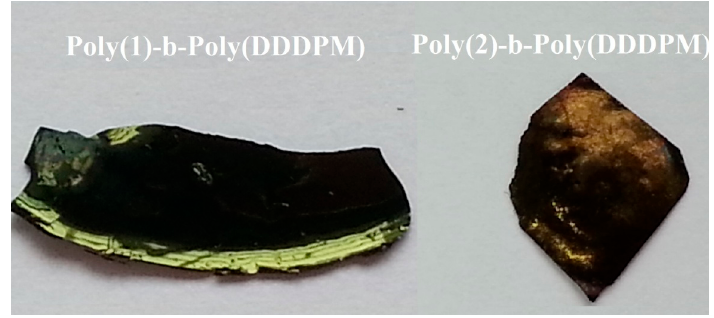
Figure 1. Picture of Poly( 1 )– b –Poly( DDDPM ) and Poly( 2 )– b –Poly( DDDPM ).